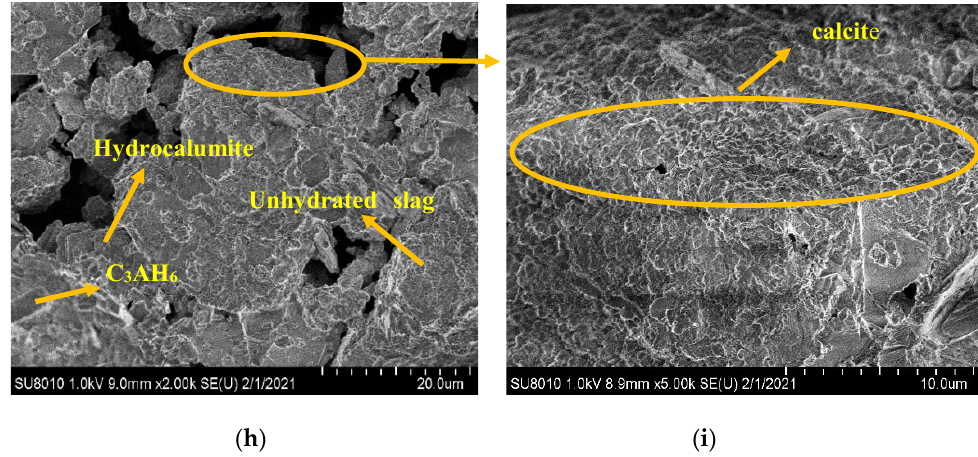
Figure 3. FESEM pictures of ( a ) raw slag 2000 × , ( b ) 20H-slag 2000 × , ( c ) 40H-slag 2000 × , ( d ) 40H- Figure 3 FESEM pictures of (a)raw slag 2000×, (b)20H-slag 2000×, (c)40H-slag 2000× , (d) 40H-slag 65 slag 8000 × , ( e ) 60H-slag 2000 × , ( f ) 60H-slag 5000 × , ( g ) 80H slag 2000 × , ( h ) 100H-slag 2000 × and 8000× , (e)60H-slag 2000× , (f) 60H-slag 5000×, (g)80H slag 2000×, (h)100H-slag 2000× and (i) 100H- ( i ) 100H-slag 5000 × .